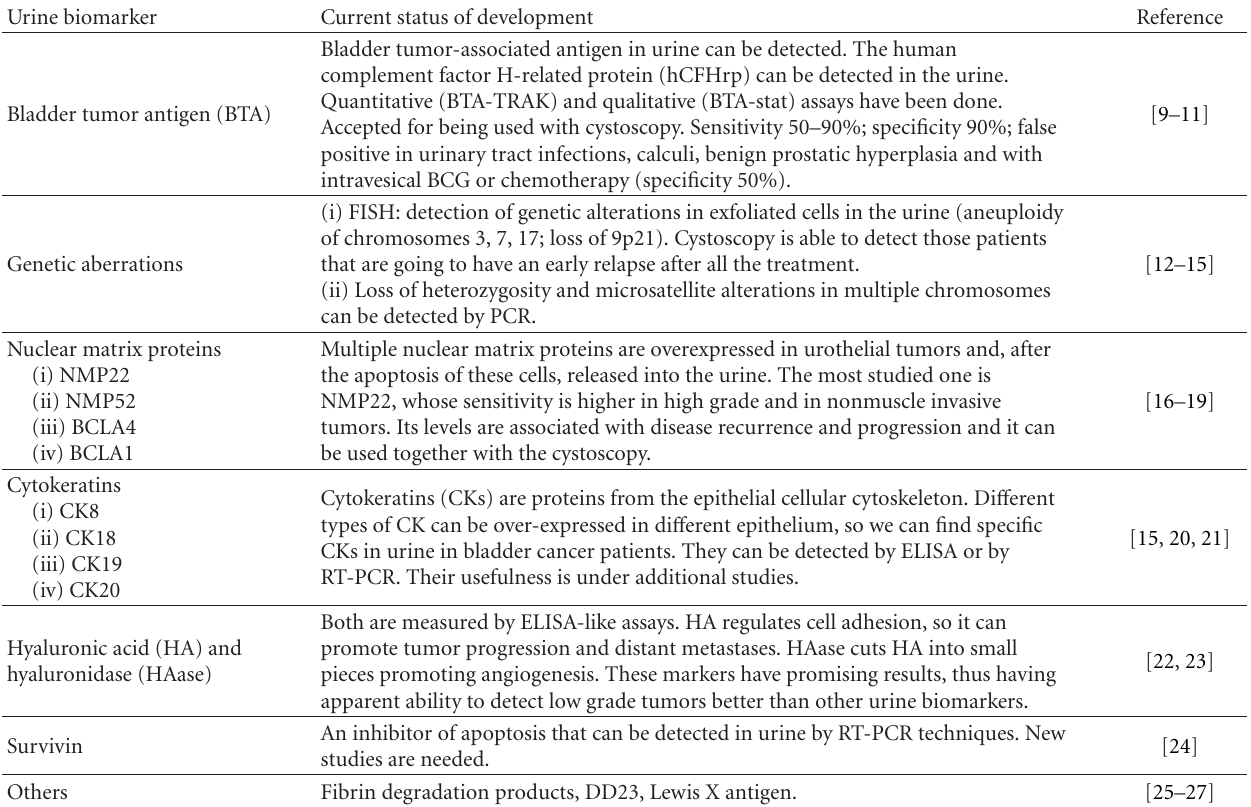
Table 2: Current and emerging urinary